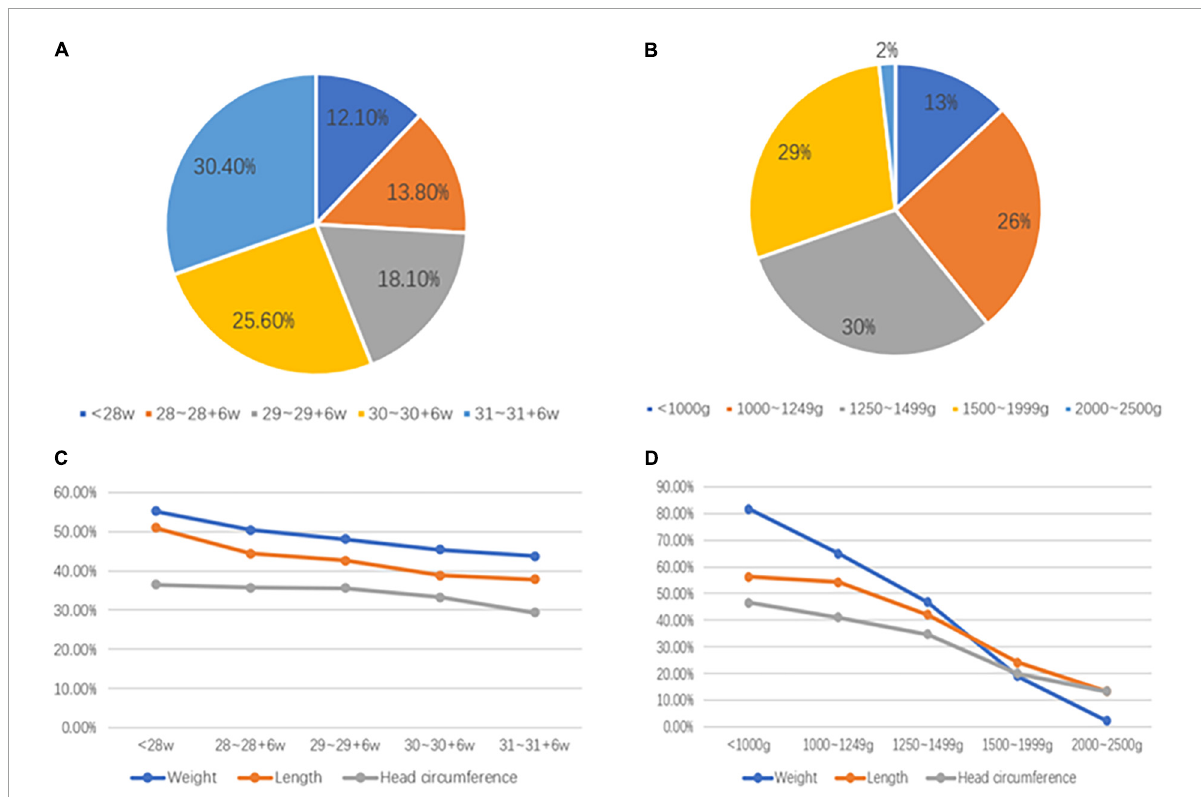
FIGURE3 The distribution of gestational age and birth weight and incidence of EUGR. ( A ) The distribution of gestational age; ( B ) The distribution of birth weight; ( C ) Incidence of EUGR stratified by gestational age, evaluated by weight, length, and head circumference; ( D ) Incidence of EUGR stratified by birth weight, evaluated by weight, length, and head circumference. EUGR, extrauterine growth